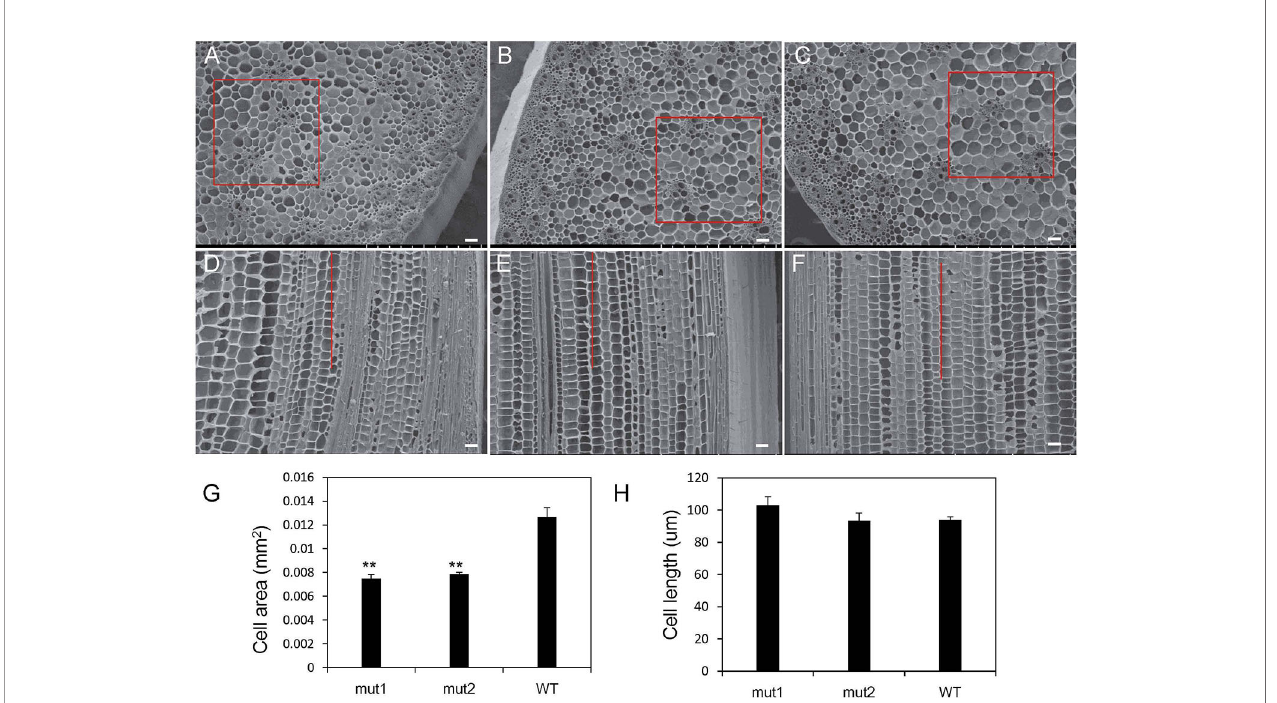
FIGURE 3 | Intercellular morphology of ga20ox3 mutant and WT plants. (A – C) showed the cross-section morphology of mut1 (A) , mut2 (B), and WT (C) plants. (D – F) showed the longitudinal sectionsof mut1 (D) , mut2 (E) , andWT (F) plants. (G) Cell area ina cross-section of the parenchyma. The cellnumbers within the 0.81 mm 2 area (the square box in A – C ) were counted and the area ofeach cellwas calculated bythe formula: 0.81 mm 2 /cellnumbers. (H) Cell length ina longitudinal section ofthe parenchyma. The cell numberswithin 1 mm distance (the lines in D – F ) were counted and the cell length was calculated bythe formula: 1 mm/cellnumbers. scale bar=0.1 mm; **indicates signi fi cant differences at the P< 0.01 level;error barsrepresent the SE of the mean (n mut1 = 6, n mut2 = 6, n WT =